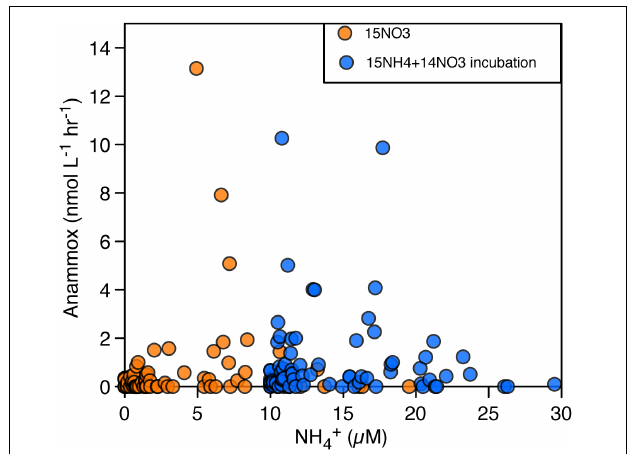
FIGURE 10 | Comparison of anammox rates vs. in situ NH 4 + concentrations (taking into account the addition of 15 NH 4 + ). In orange, rates of anammox obtained through the production of 29 N2 with the addition of 15 NH 4 + and 15 NO 3 − . In blue, rates of anammox obtained through the production of 29 N2 with the addition of 15 NO 3 − .